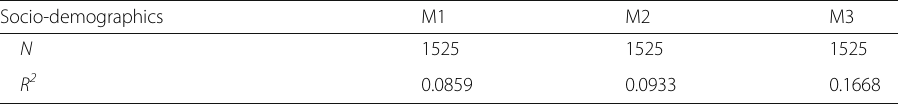
Table 10 Determinants of rural elders ’ self-rated health (Continued)